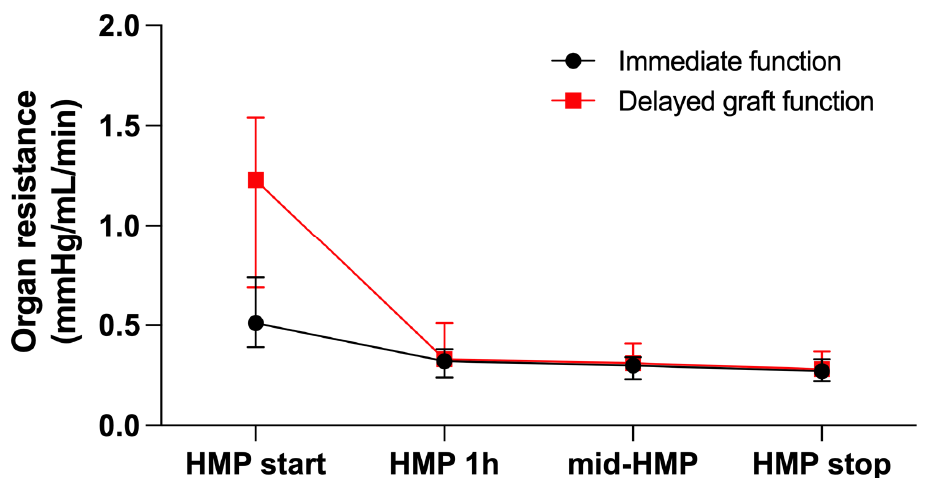
Figure 3. Organ resistance during hypothermic machine perfusion (HMP) according to graft function. Data are presented as median (interquartile range).